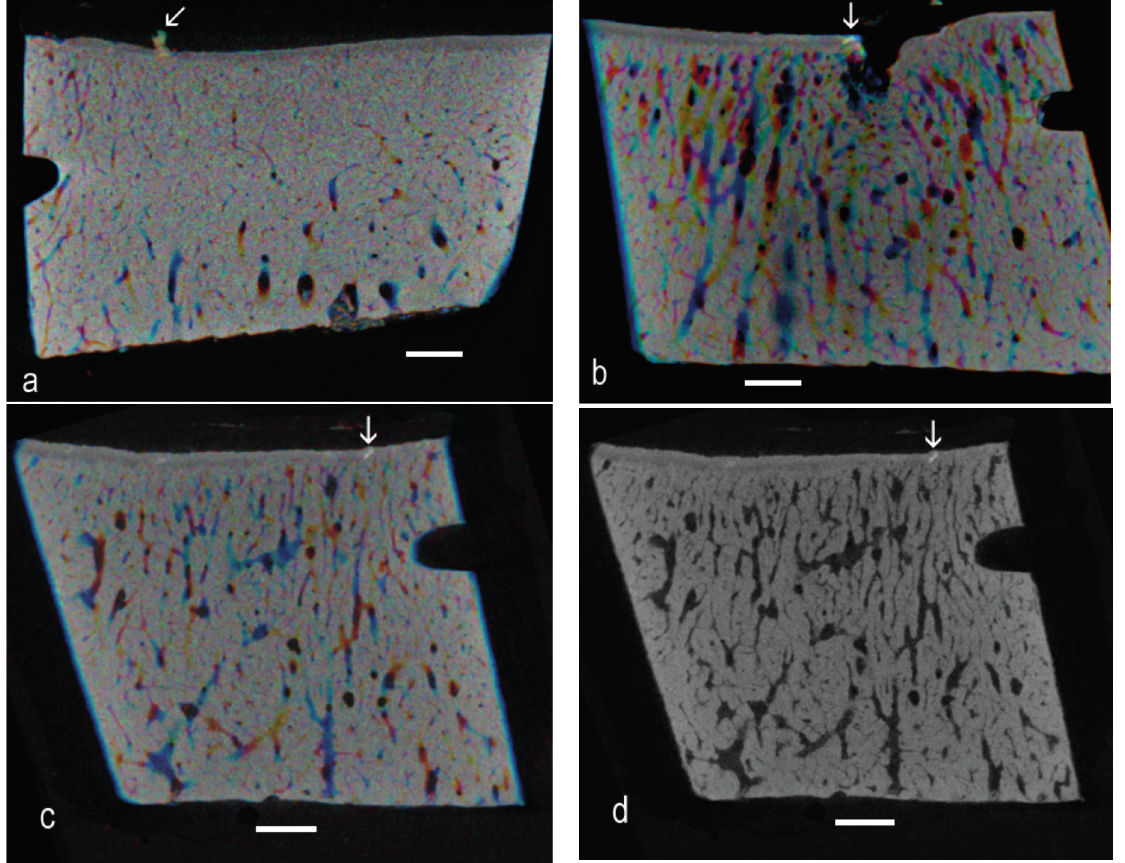
Figure 3. ( a ) Successive eight-bit grey level images (averages of two original Z levels) images assigned as Red, Green and Blue: matching brighter patches show as whiter against a colored background. Advanced OA, seven-year-old; ( b ) From sample from an eight-year-old that showed the highest number of easily-spotted HDMI fields in a control sample. Successive averages of four grey level images displayed as R, G and B components in a composite image; ( c ) Another region from the same sample; six sequential Z planes summed in pairs, then pairs displayed as RGB components; and ( d ) Same six planes processed to retain the darkest